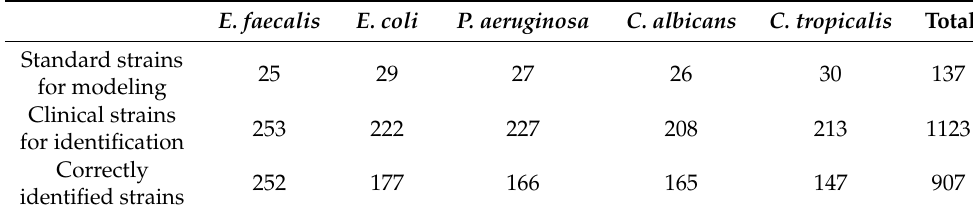
Table 1. Classification results obtained by the multi-classifier voting